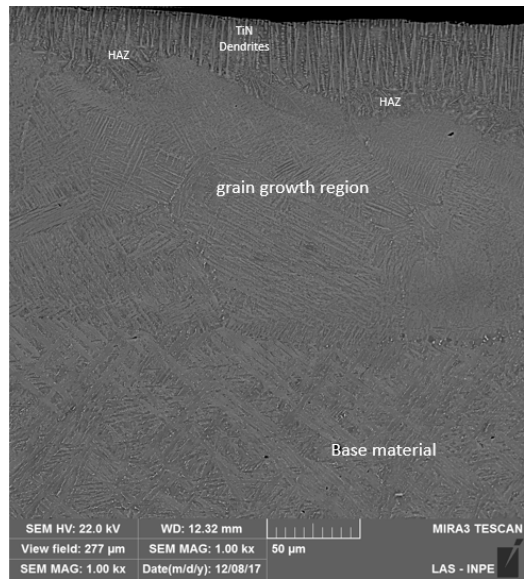
Figure 4. Longitudinal SEM of Widmanstätten microstructure after laser nitriding. Laser Power: 800 W.